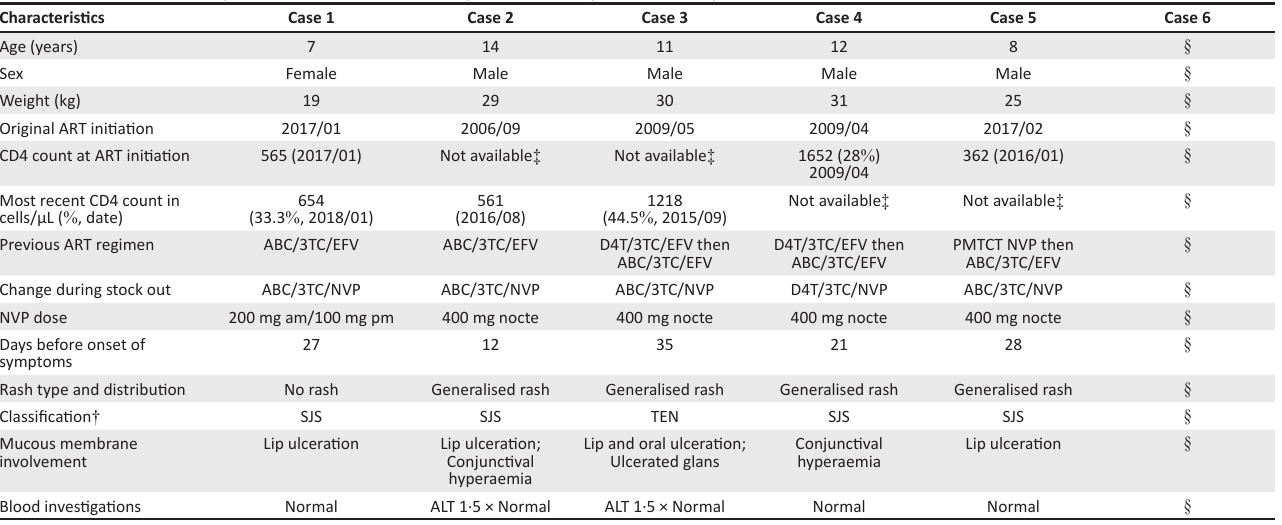
TABLE 1 : Case information of patients with Stevens-Johnson syndrome/toxic epidermal necrolysis. Characteristics